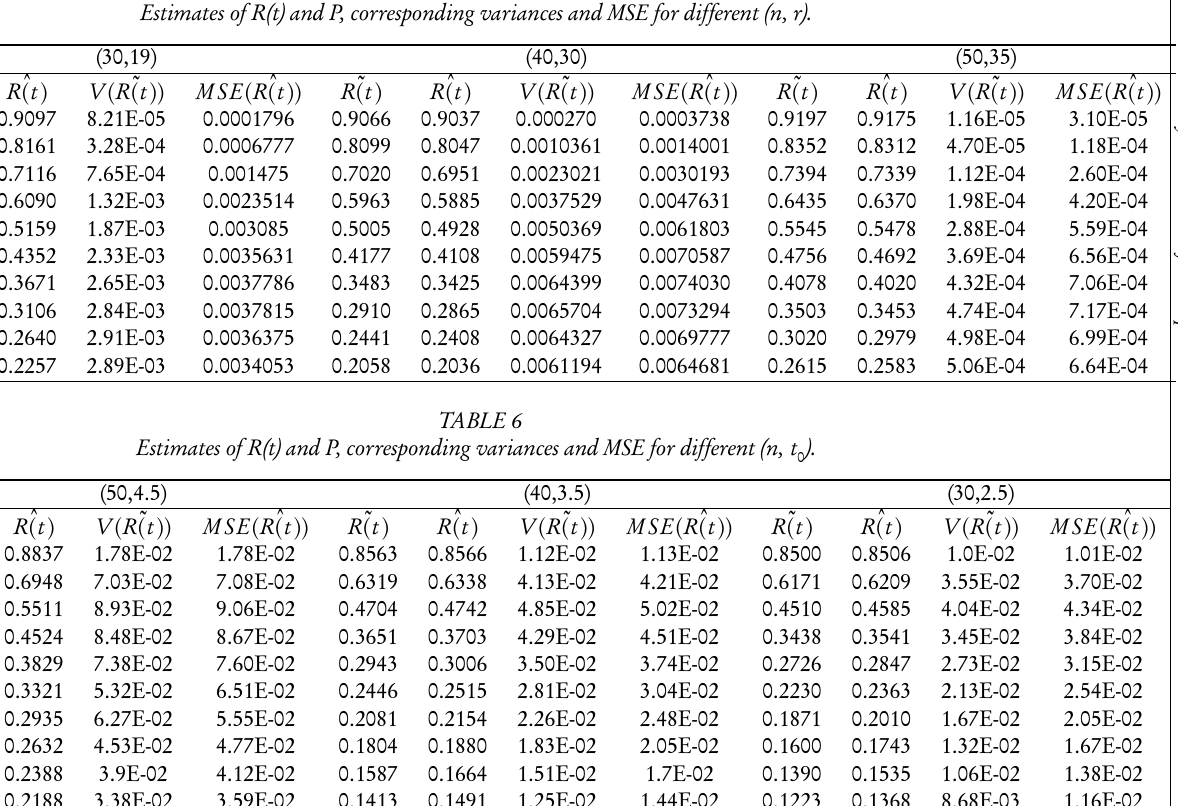
Estimates of R(t) and P, corresponding variances and MSE for different (n, r).